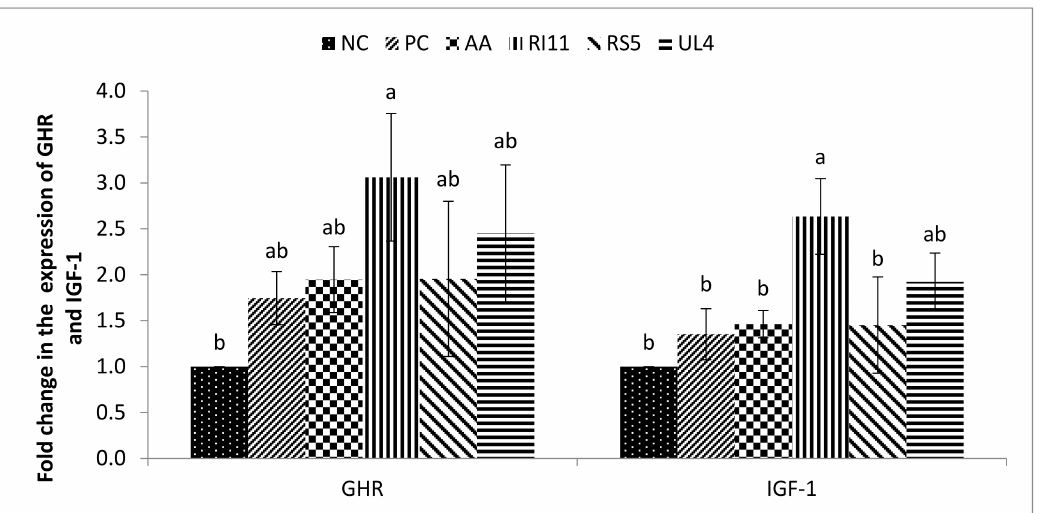
Figure 2. Hepatic GHR and IGF-1 mRNA expression level in broiler chickens fed di ff erent postbiotics under heat stress. a–c Di ff erent letters on standard error bars indicate significant di ff erence ( p < 0.05). Data are shown as means and standard error (n = 7). GHR = growth hormone receptor, IGF-1 = insulin-like growth factor 1. Treatments: Negative control (NC) = basal diet, positive control (PC) = basal diet + oxytetracycline 0.02% ( w / w ), AA = ascorbic acid 0.02% ( w / w ), RI11 = postbiotic RI11 0.3% ( v / w ), RS5 = postbiotic RS5 0.3% ( v / w ), UL4 = postbiotic UL4 0.3% ( v / w